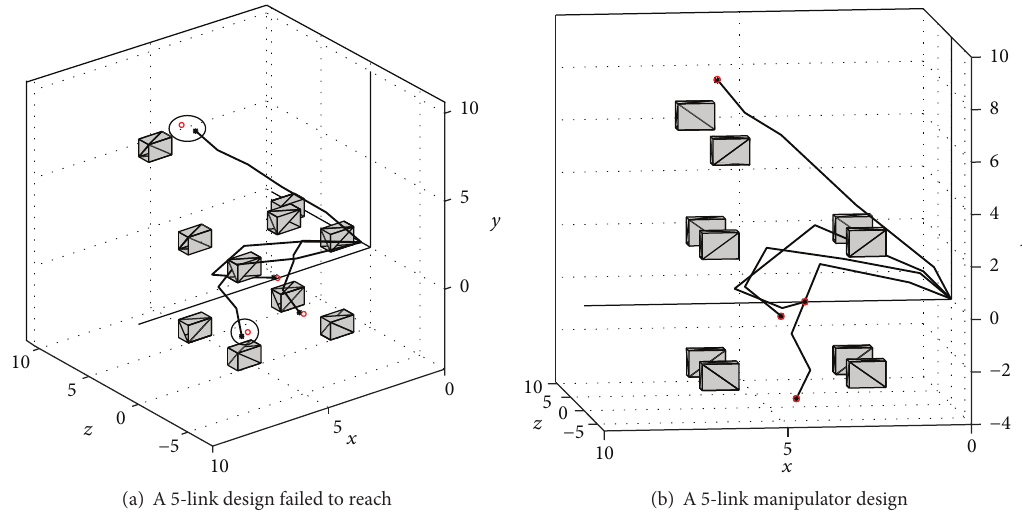
Figure 6: A 5-link design by varying the limits of the design variables.